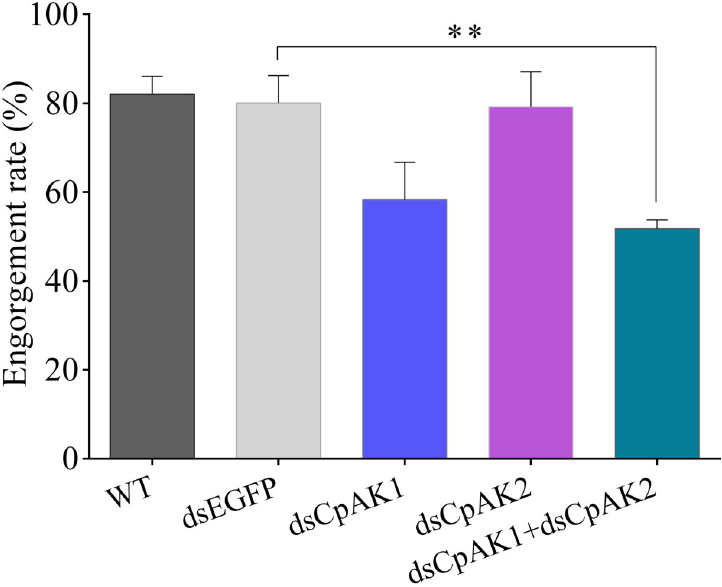
Fig 9. The engorgement rate of female mosquitoes in different treatment groups. All data were expressed as the mean ± Standard Error (SE). Significant difference was analyzed by one-way ANOVA test ( �� P < 0.01).